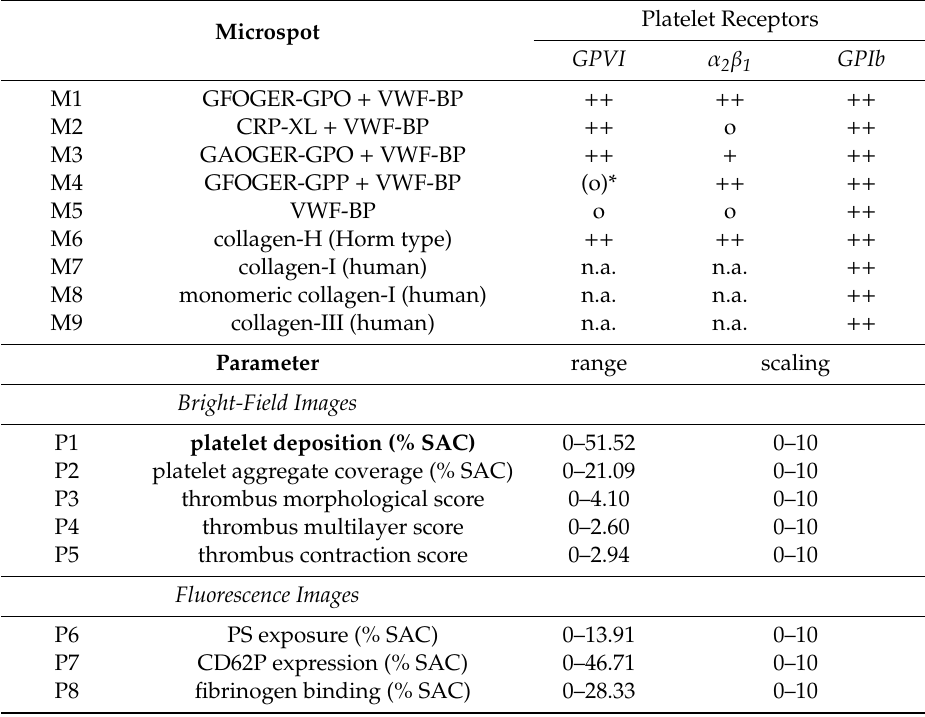
Table 1. Overview of composition of microspots (M1–9), platelet receptors implicated in thrombus formation. Also indicated are the analyzed thrombus parameters (P1–8) from bright-field and fluorescence microscopic images. Measured ranges and scaling for heatmap analysis were as indicated. GP: Glycoprotein; PS: Phosphatidylserine; VWF-BP: von Willebrand factor binding peptide, SAC: Surface area coverage, n.a., not